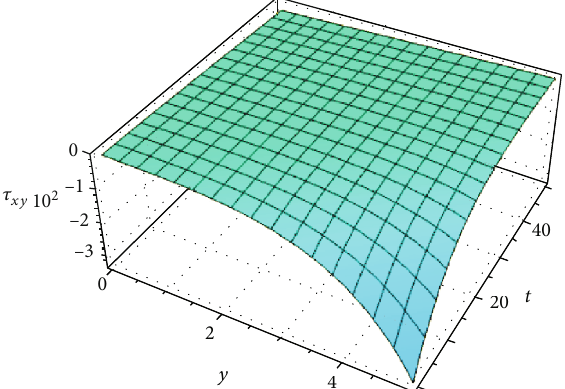
Figure 5: The induced electric fi eld E